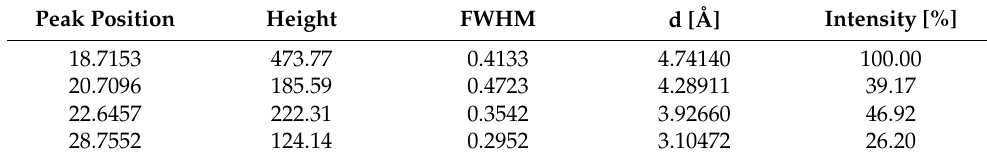
Table 5. Basic diffraction spectral parameters of PEEK ‐ 5.